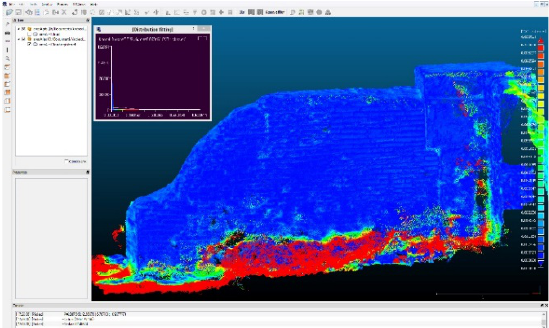
Fig. 24 Cloud to Cloud distance evaluation between dense cloud of Photoscan and point cloud of laser scanner about architecture at Insula Volusiana: “fixed scale” function is